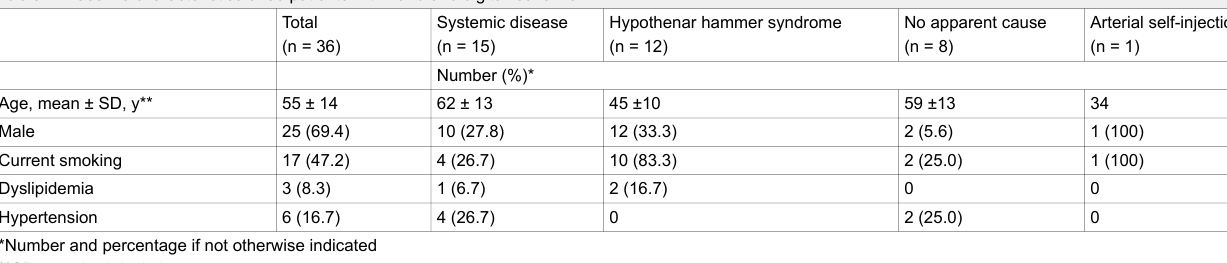
Table 2: Severity of symptoms at baseline in all 36 patients and separated by etiology. Severity of symptoms